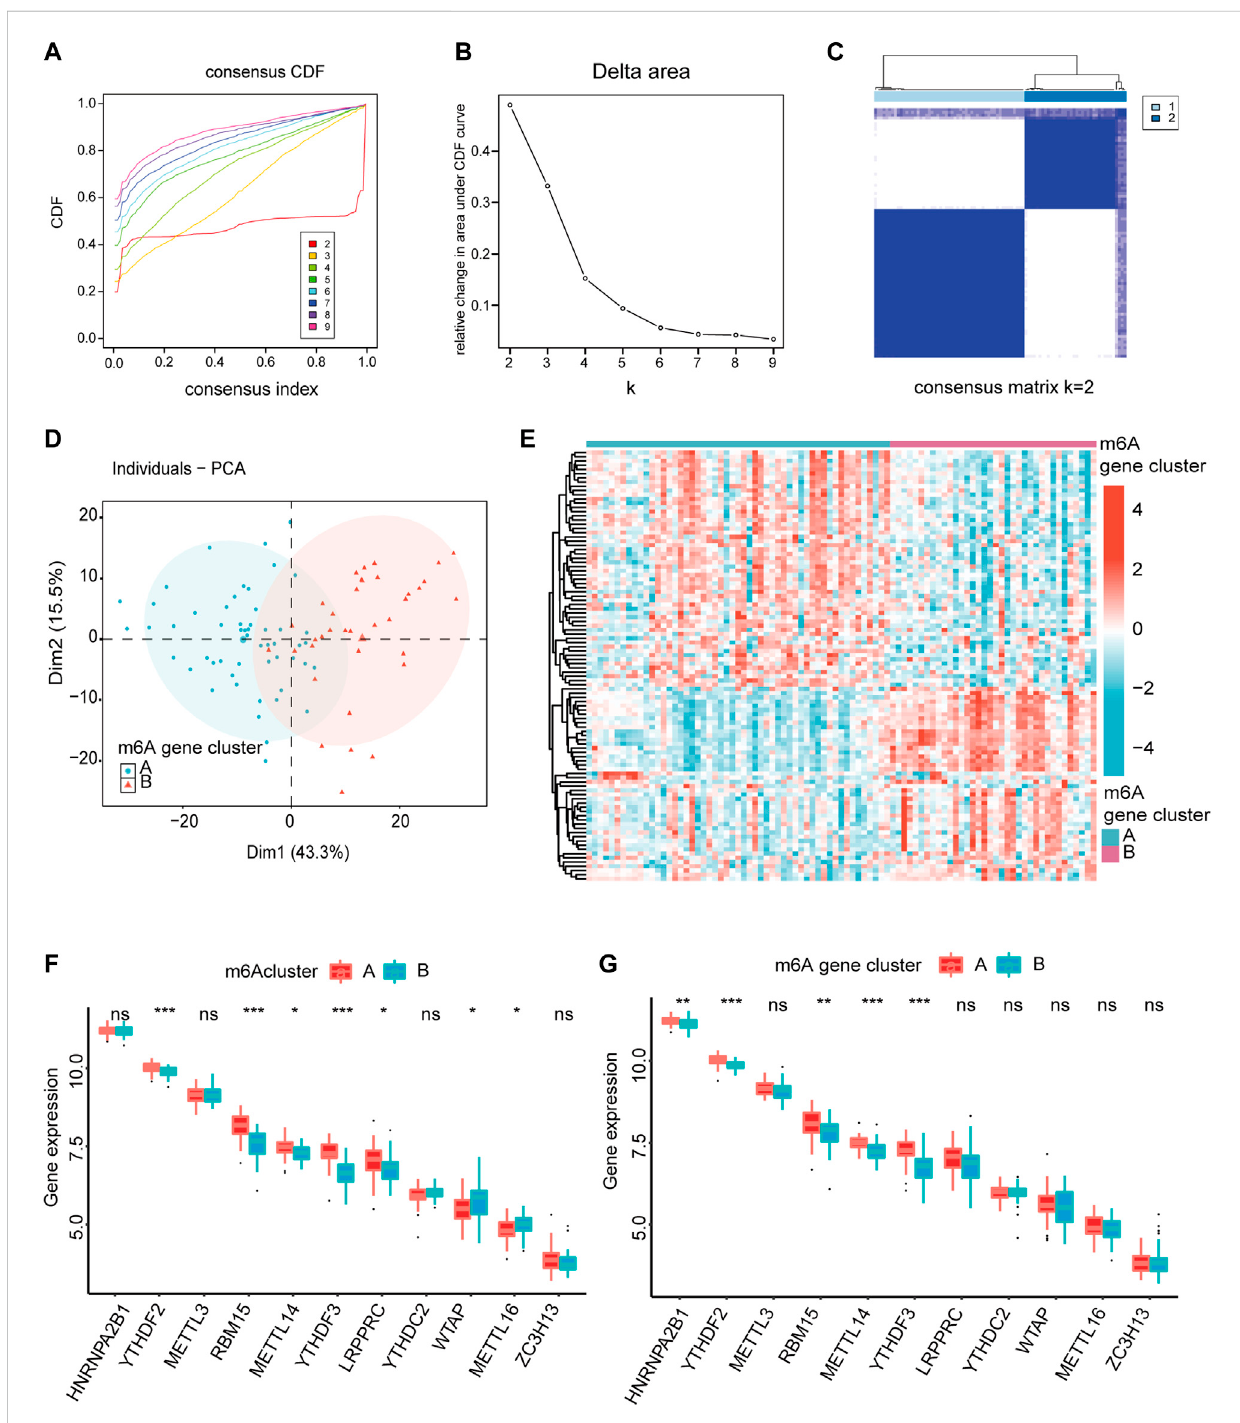
FIGURE 5 The heterogeneity of m6A regulators could be found in IS. (A) Consensus clustering CDF for k = 2 – 9. (B) Relative change in area under CDF curve fork=2 – 9. (C) IS samplesweredividedinto twom6A geneclusterswhen k=2. (D) The PCAanalysis for theexpressionpro fi les oftwom6Agene clusters has few overlaps. (E) Expression heatmap of the 436 m6A-related DEGs in two m6A gene clusters. (red: high expression; blue: low expression). (F,G) The different expression status of m6A regulators between the two m6Aclusters and two m6A gene clusters. The lower and upper ends of the boxes represent the interquartile range of values. Outliers are represented by black dots in the boxes, and medians by lines. * p < 0.05, ** p < 0.01, and *** p < 0.001, “ ns ” indicates no signi fi